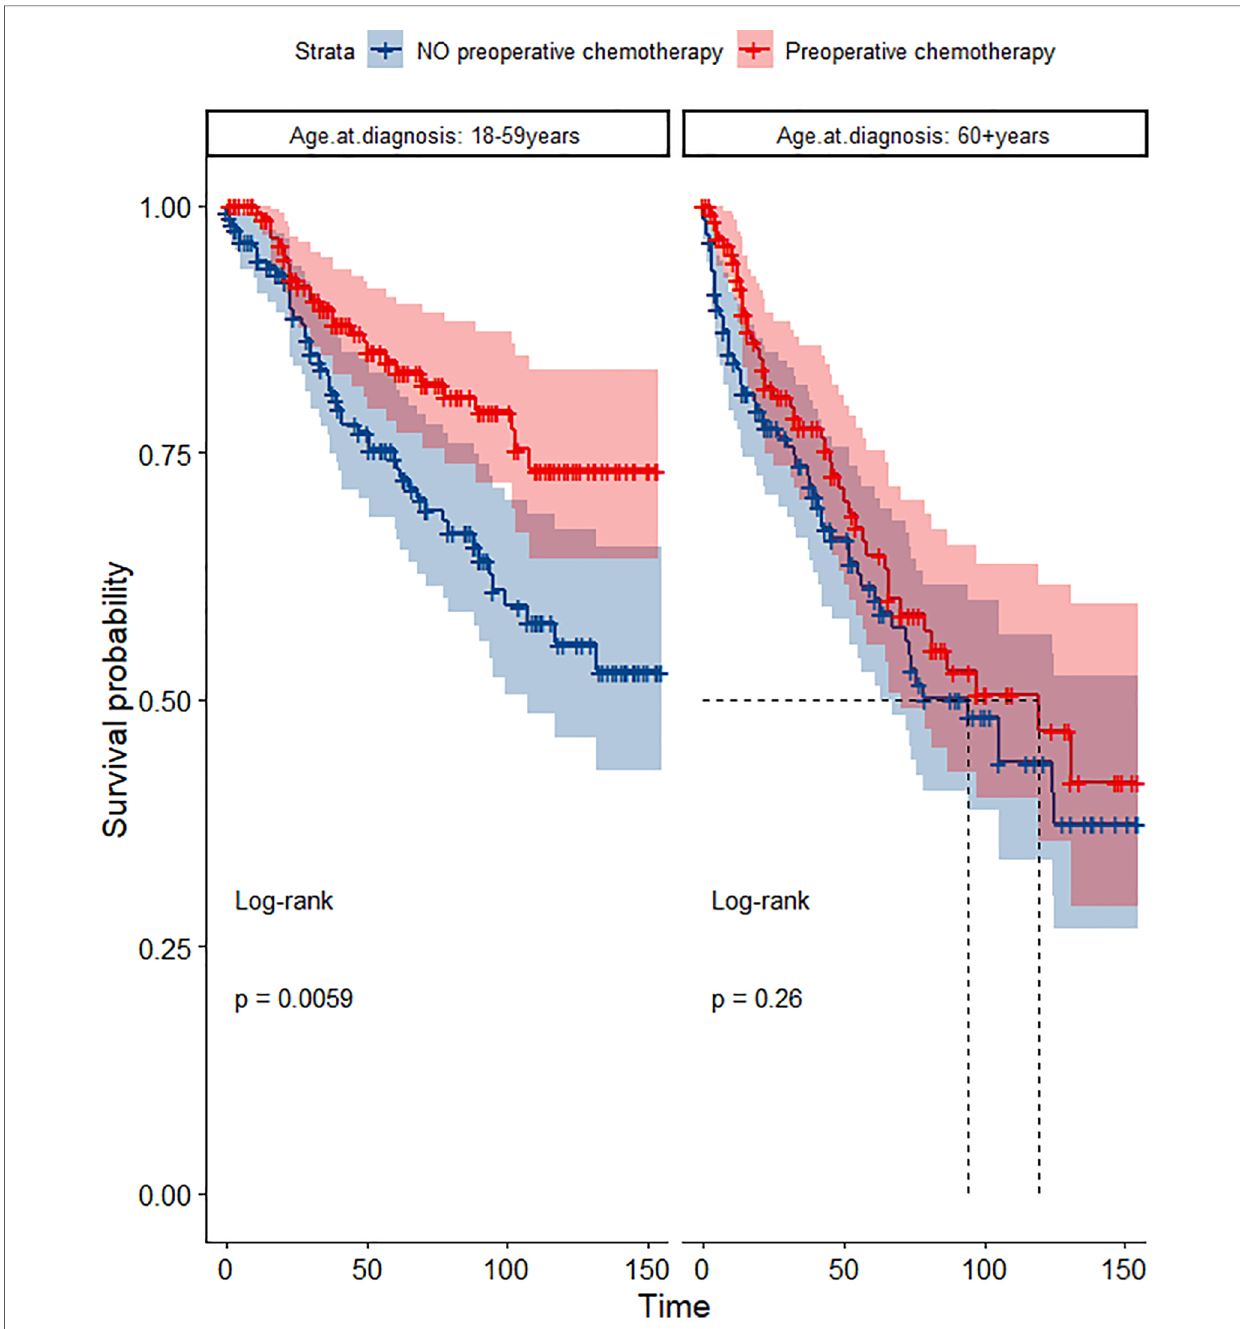
FIGURE 9 Survival curves of OS in the POCT and no POCT groups in patients undergoing surgery for TETs in different age groups after propensity